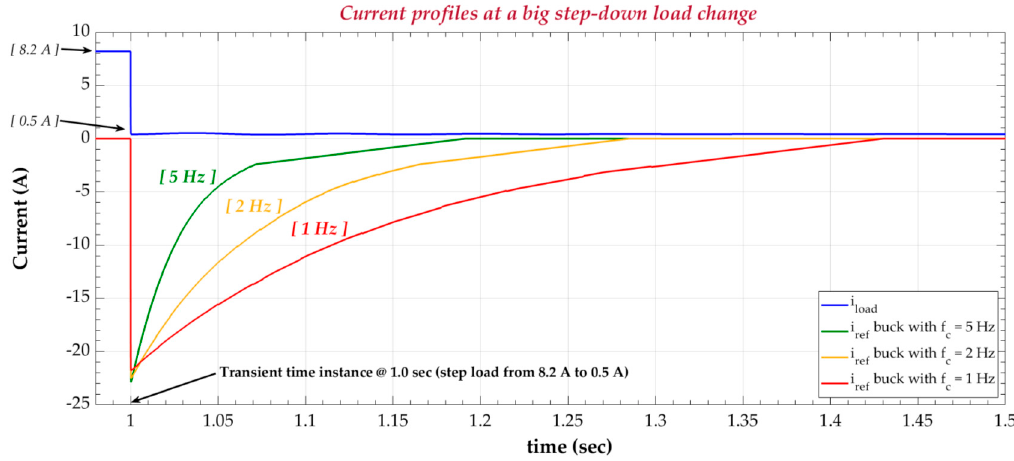
Figure 11. Inductor current reference for a voltage swell case, with LPF cutoff frequency as a parameter.